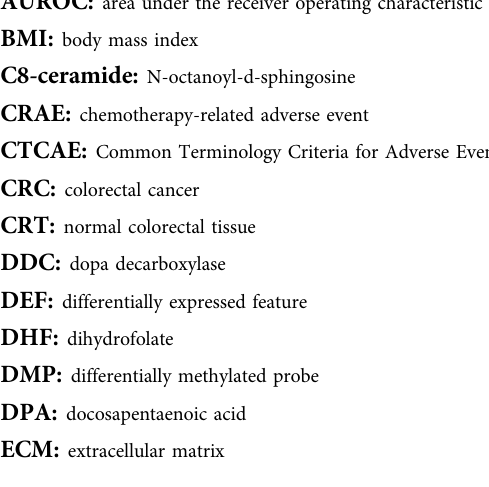
FC: fold of change FFQ: food-frequency questionnaire FPKM: fragments per kilobase of transcript per million fragments mapped HFS: hand-foot